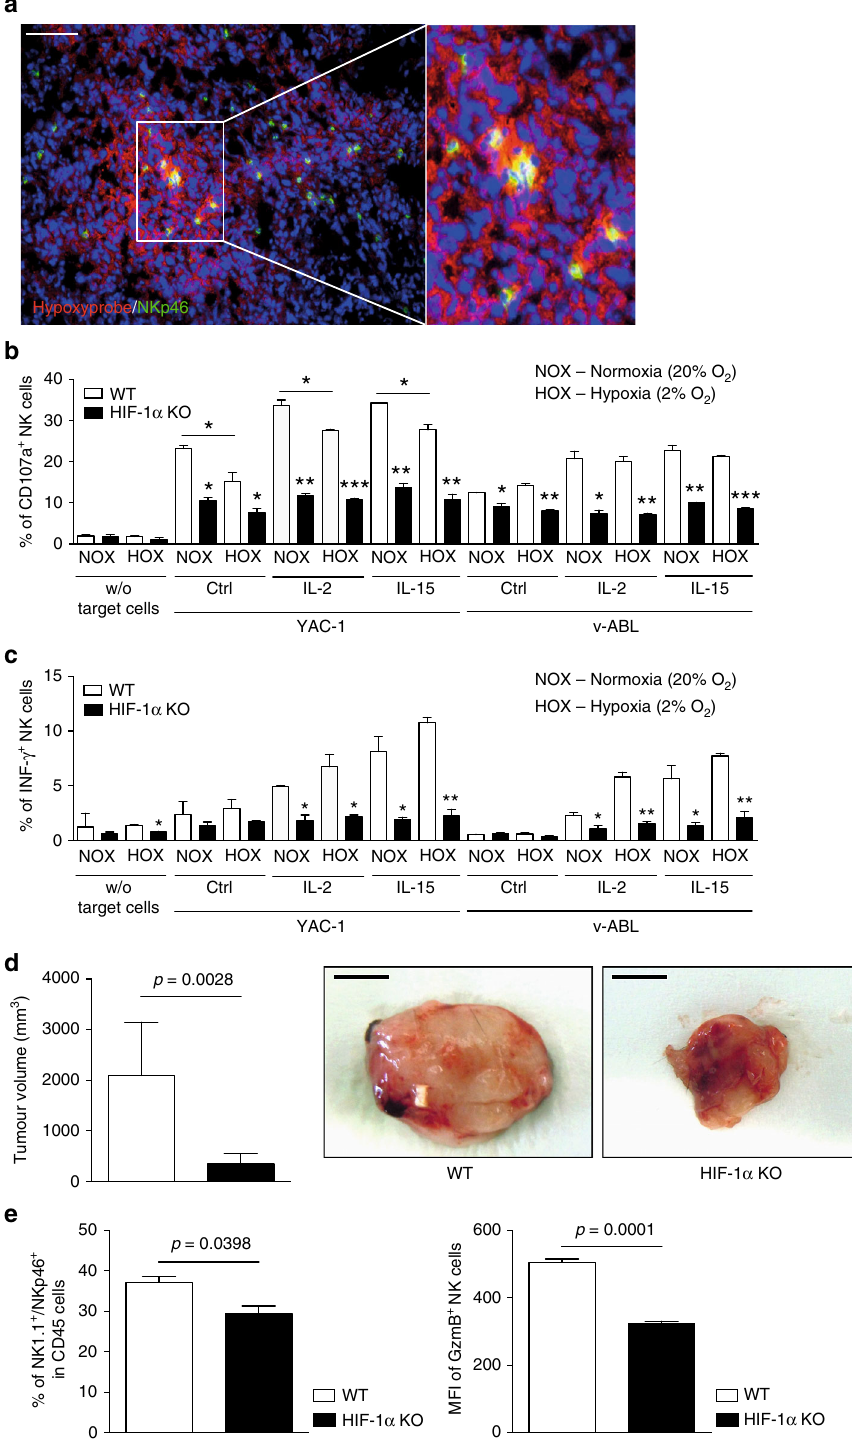
Fig. 1 HIF-1 α depletion in NK cells results in decreased cytotoxicity but delays tumour growth. a Representative image of tumour hypoxia in LLC isografts with the speci fi c markers Hypoxyprobe (red), NKp46 (green), and nuclei (blue). b Splenocytes from WT and HIF-1 α KO mice were stimulated with target cells (YAC-1 and V-abl lymphoma cells, Ratio E/T 1:1), in absence or presence of rhIL-2 and rmIL15. NK cell degranulation (CD107A + ) and c INF- γ expression were analysed by fl ow cytometry ( n = 4 for each group). d Tumour volume analysis of V-abl tumours injected subcutaneously in WT and HIF-1 α KO mice with representative images at endpoint, day 21 ( n = 11 for each group). Scale bars in macroscopic fi gures indicate 5 mm. e Flow cytometry analysis for NK1.1, NKp46 (for NK cells), GzmB (for NK cell activation state) on V-abl tumours from WT and HIF-1 α KO mice at endpoint, day 21 ( n = 3). Statistical signi fi cance was determined by an unpaired Student ’ s t -test or one-way analysis of variance, where appropriate. Bars represent mean values; error bars indicate the s.e.m. Statistical signi fi cance is indicated as * P < 0.05, ** P < 0.01, and *** P < 0.001. Scale bar, 100 μ